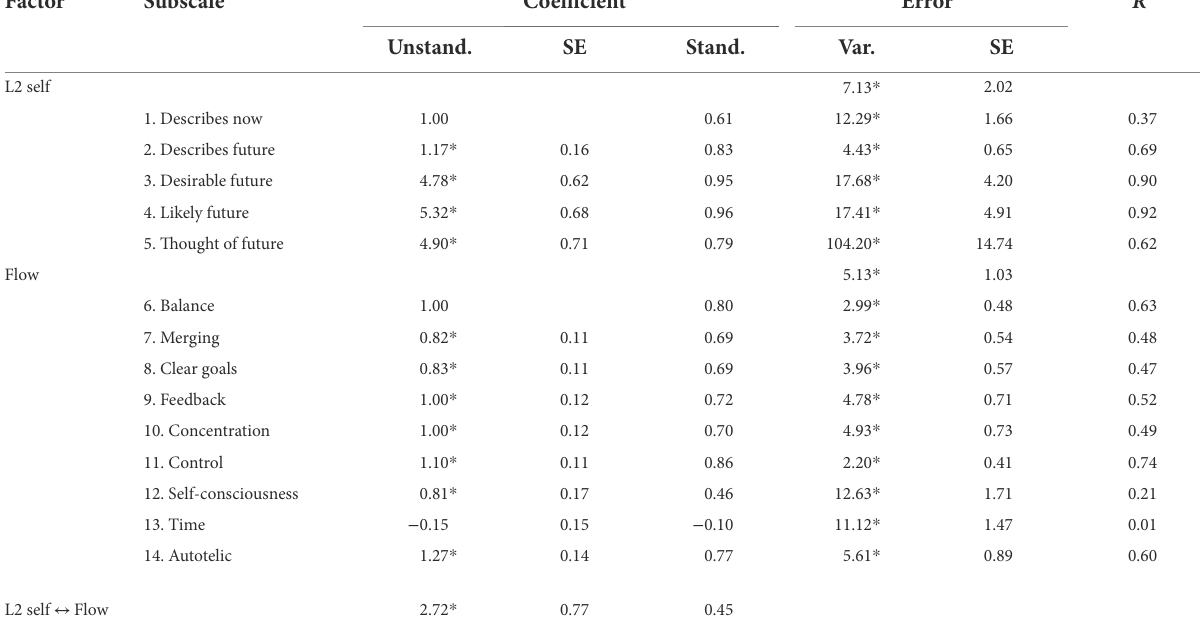
TABLE 2 Parameter estimates of the confirmatory factor analysis model ( N = 116). Factor